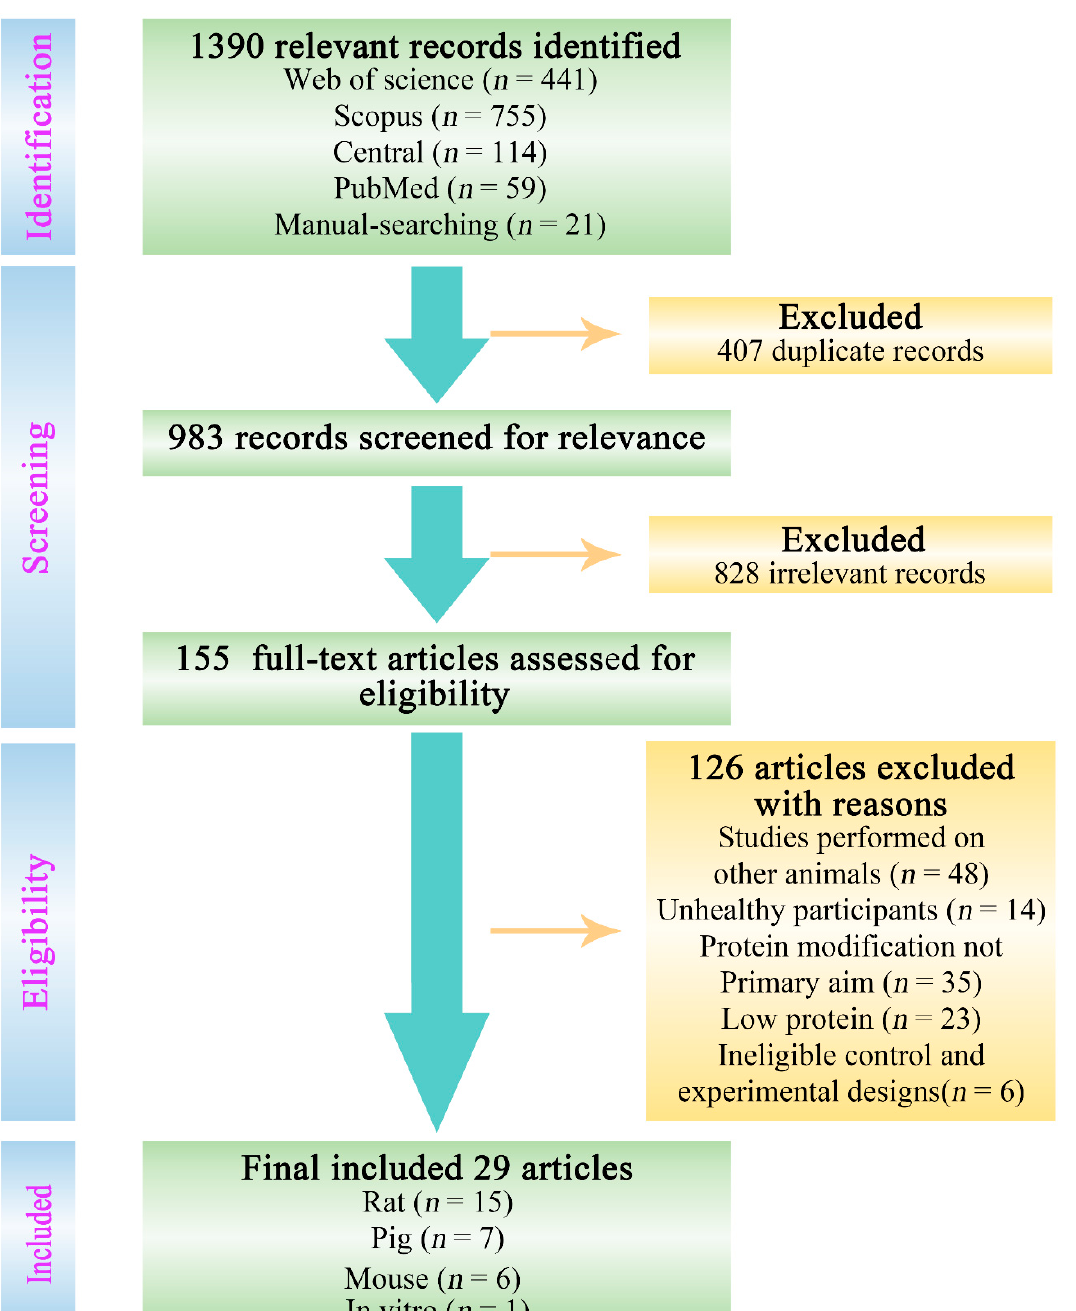
Figure 1. Flowchart detailing the process of identifying and selecting studies.